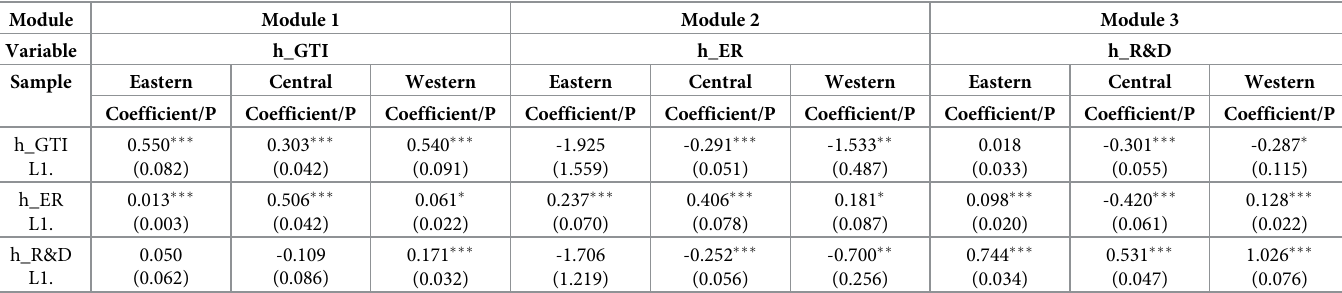
Table 5. Estimation results of GMM parameters of PVAR model.